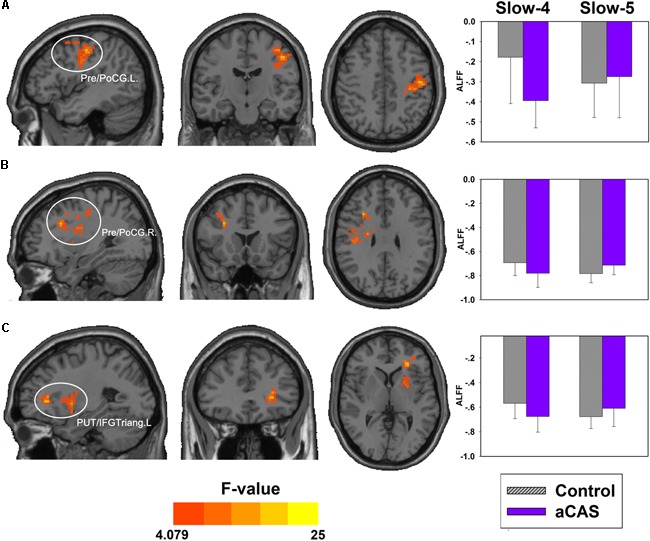
Interactions between group and frequency bands (slow-4 and slow-5). The regions showing significant interactions on ALFF (hot colors) includes: (A) the left precentral and postcentral cortex, (B) the right precentral and postcentral cortex, and (C) left putaman and Inferior frontal gyrus triangular part. The bar maps show the mean ALFF values in these regions.